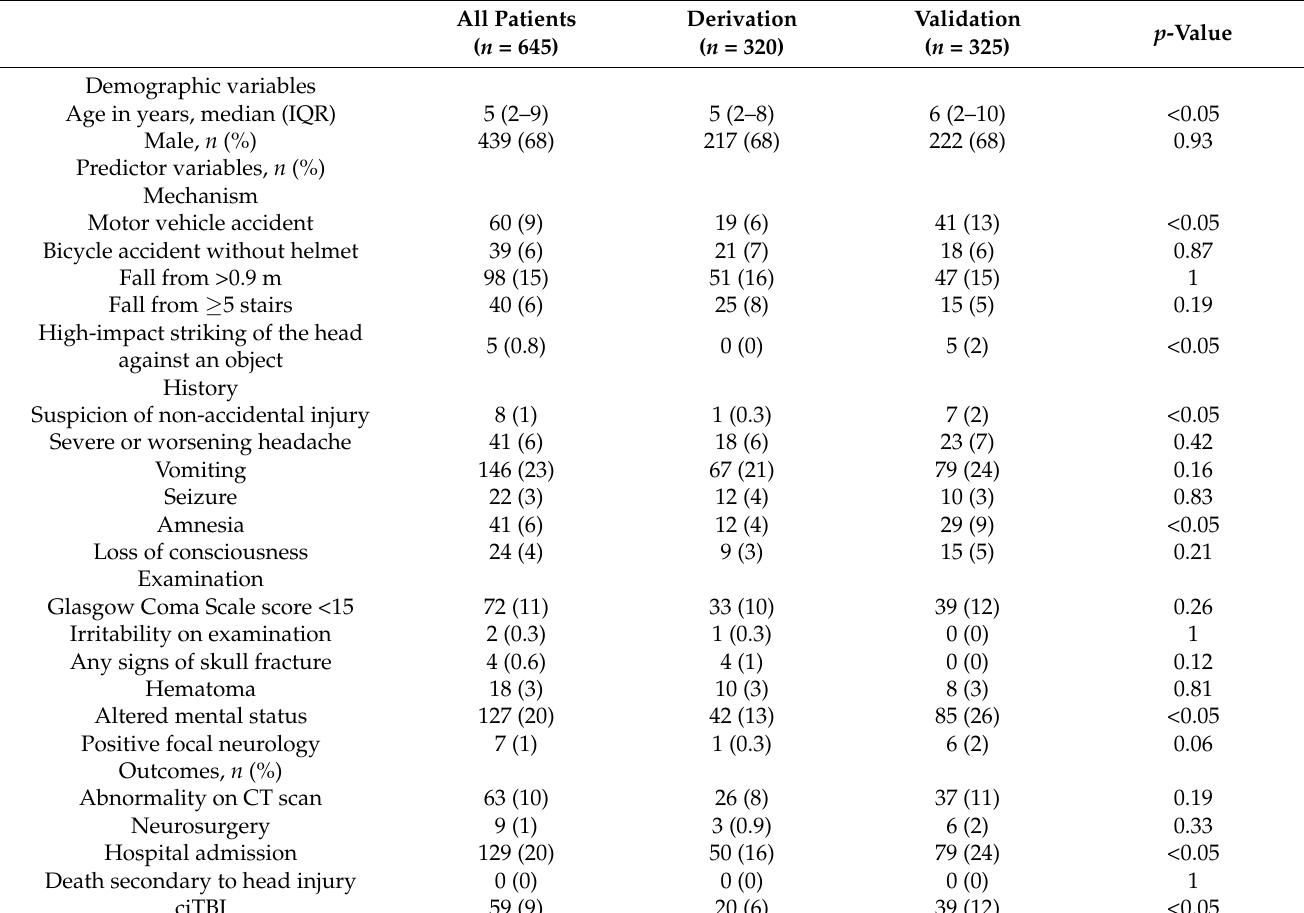
Table 2. Distribution of demographic variables, predictive variables, and